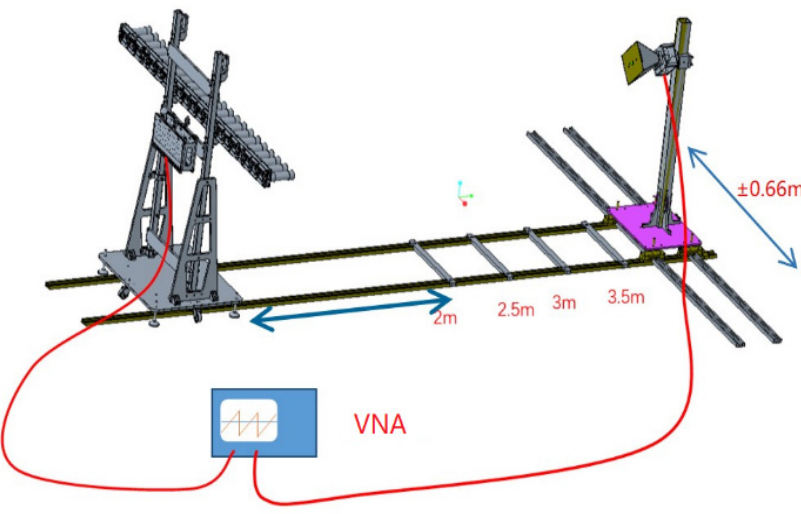
Figure 14. Schematic diagram of the verification scheme for the plane wave quiet zone performance test of the antenna array.